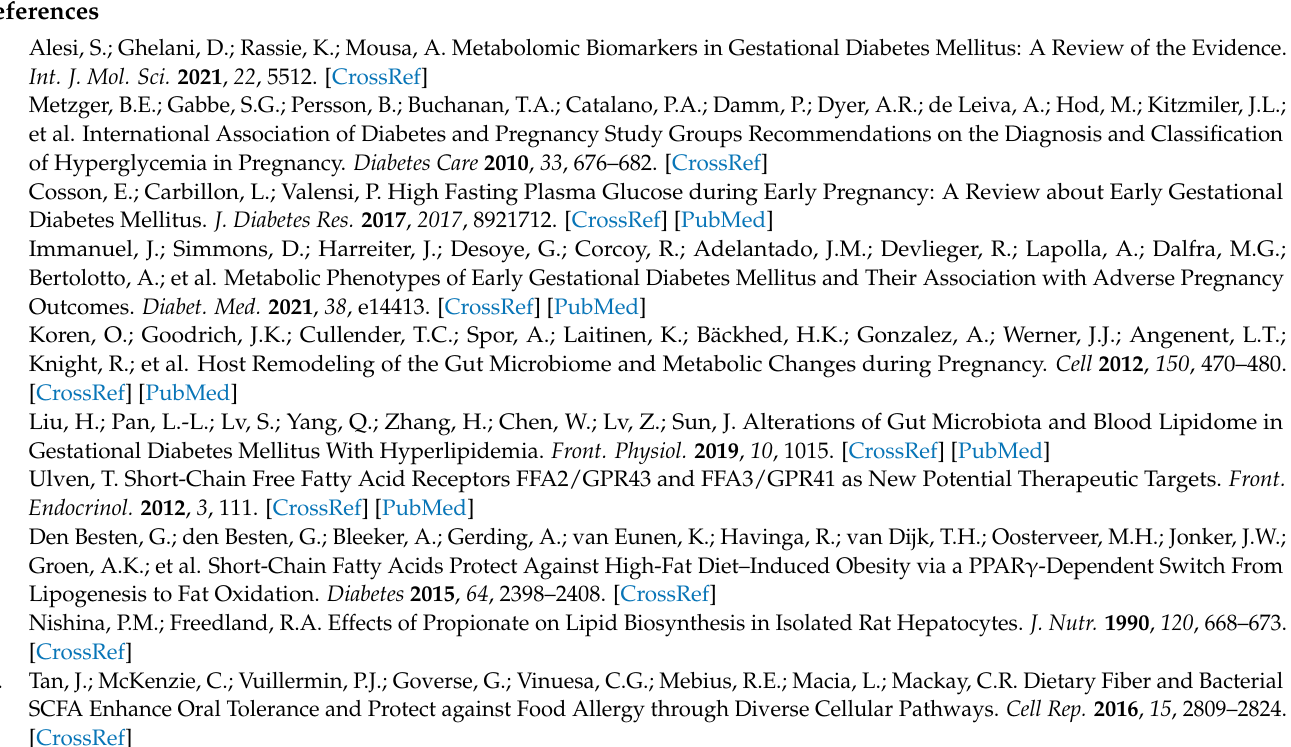
P-GDM-2/3T-ppg group. Critical value of significance is r = 0.4044. Red/blue color corresponds to positive/negative correlation and color saturation represents the degree of correlation. Figure S10. Pearson’s correlation (n = 20) of SCFA and their derivatives with baseline body composition charac- teristics and biochemical biomarkers for P-nonGDM group. Critical value of significance is r = 0.4227. Red/blue color corresponds to positive/negative correlation and color saturation represents the degree of correlation. Figure S11. Pearson’s correlation (n = 20) of SCFA and their derivatives with baseline body composition characteristics and biochemical biomarkers for nonP group. Critical value of significance is r = 0.4227. Red/blue color corresponds to positive/negative correlation and color saturation represents the degree of correlation. Table S1. MS/MS parameters transitions and analytical parameters for SCFA, their derivatives and IS. Table S2. Linearity, LOD, LOQ and ULOQ of SCFA and their derivatives. Table S3. The baseline body composition characteristics of each group. Table S4. The biochemical parameters of each group. Table S5. The concentrations of SCFA and their derivatives of each group. Table S6. ANOVA test comparing mean values of SCFA and their derivatives. p -value < 0.05 is statistically significant (bold). Table S7. ANOVA test comparing mean values of baseline body composition characteristics and biochemical parameters. p -value < 0.05 is statistically significant (bold). Table S8. Fold-change values between the groups of women with GDM and